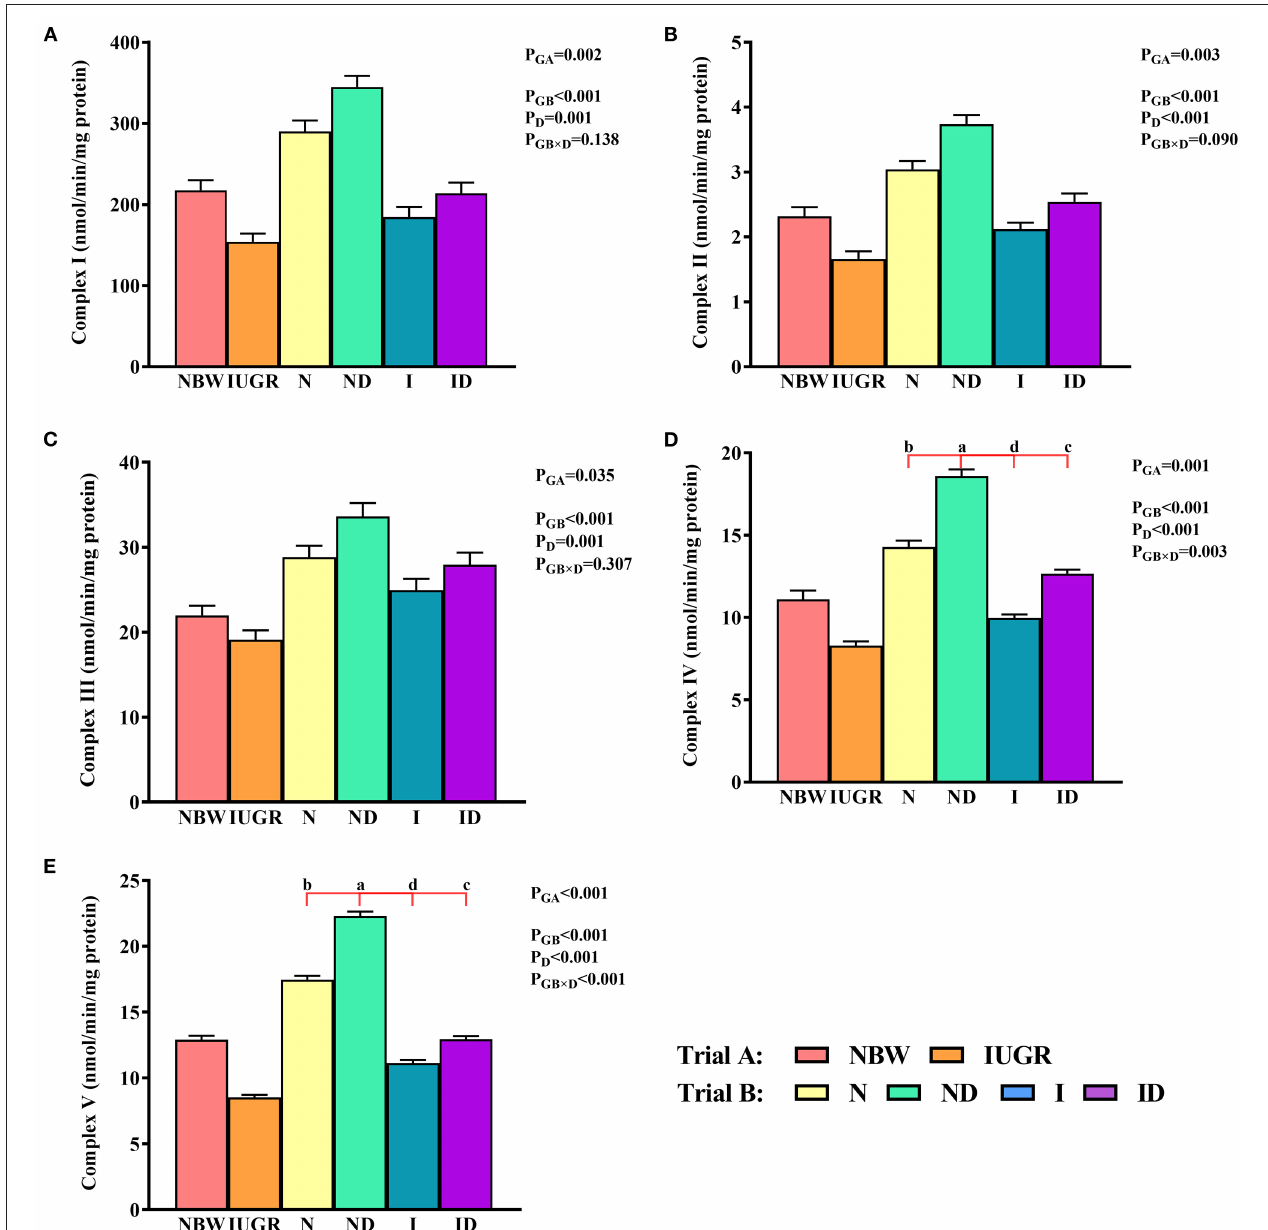
FIGURE 6 | (A–E) Supplementation with DMG-Na improved the hepatic mitochondrial ETC complexes in IUGR suckling piglets. Data are expressed as the mean ± SD; n = 10 suckling piglets per group. The P -value (Trial A: NBW, IUGR group in black color) and a, b, c, d (Trial B: N, ND, I, ID group in red color) represent significant differences ( P < 0.05). NBW, normal birth weight newborns; IUGR, intrauterine growth restriction newborns; N, NBW newborns fed a basic milk diet; ND, NBW newborns fed a basic milk diet plus 0.1% DMG-Na; I, IUGR newborns fed a basic milk diet; ID, IUGR newborns fed a basic milk diet plus 0.1%